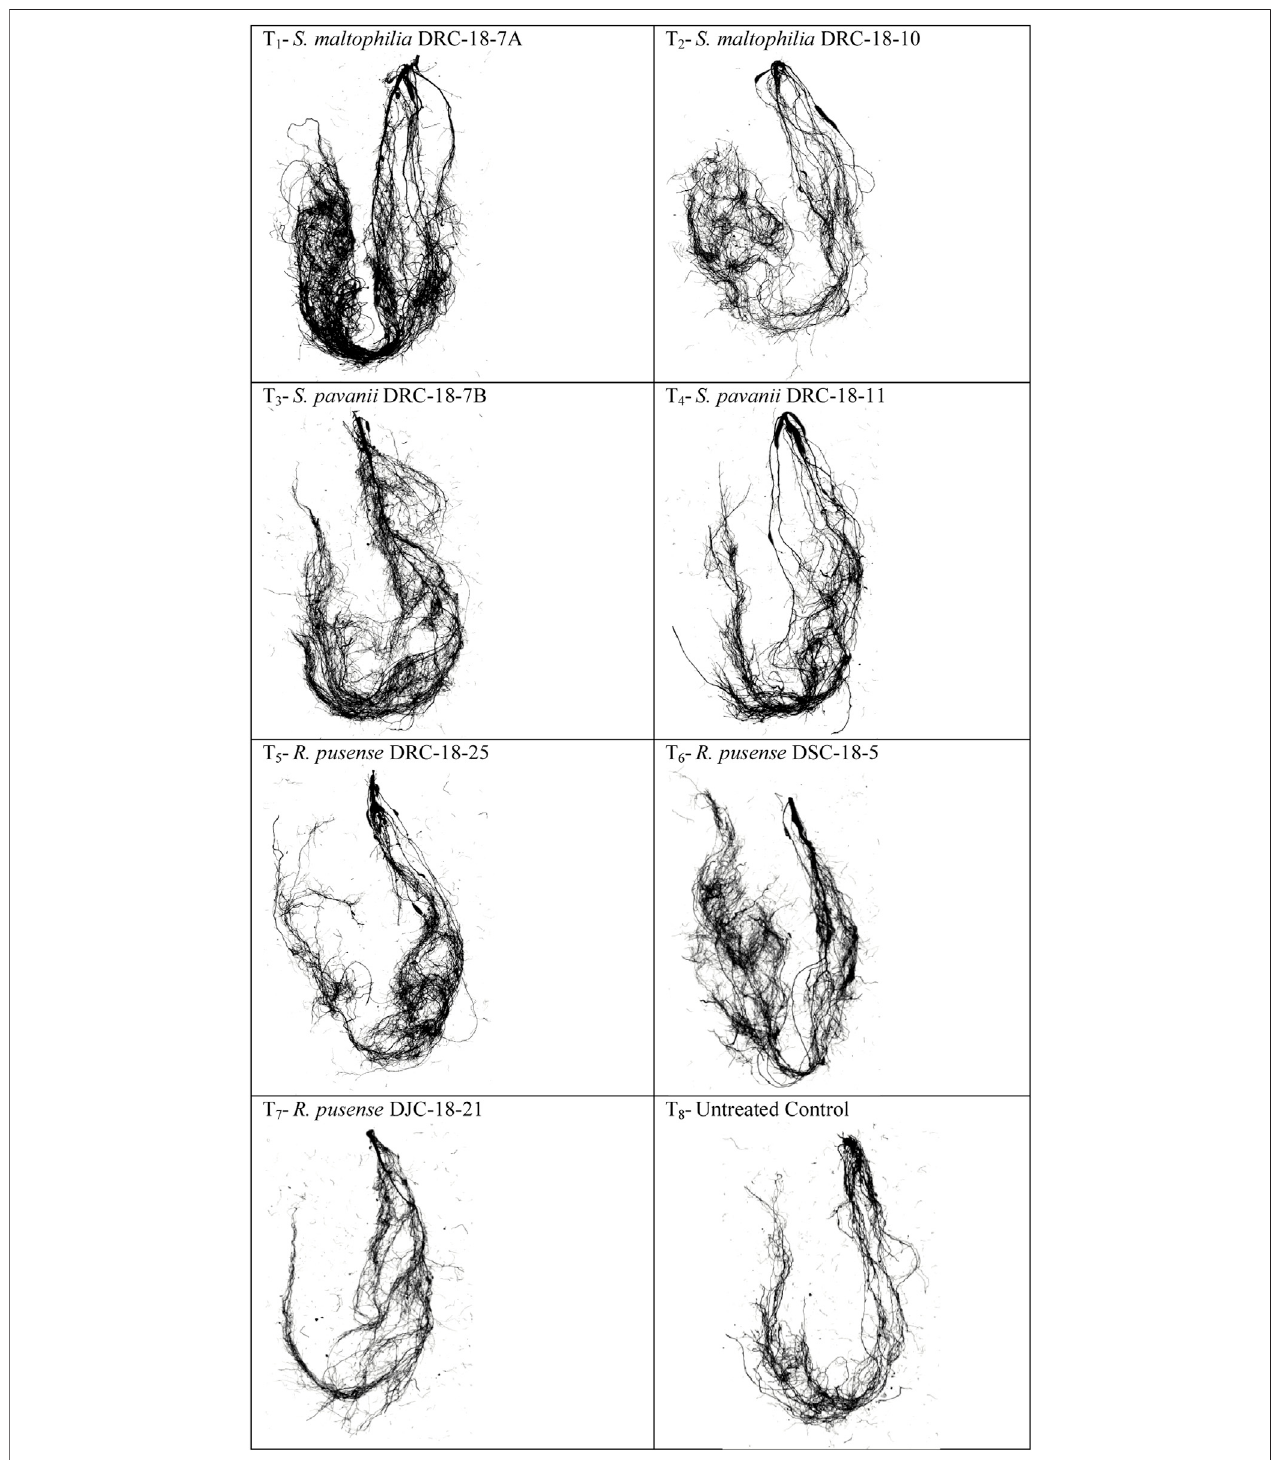
FIGURE 5 | Effects of seed inoculation of SOB on root architecture in the pigeonpea leaves at 30 days of sowing.